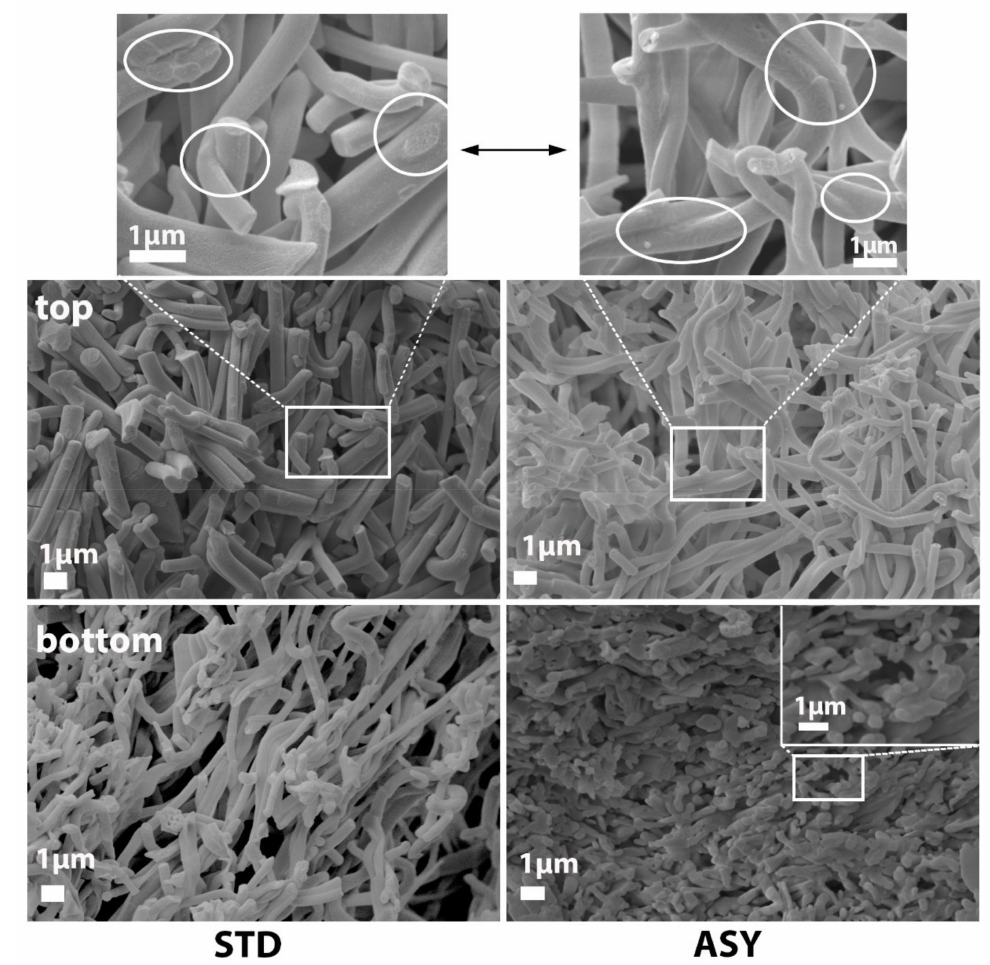
Figure 6. Comparative SEM micrographs of the ( top ) and ( bottom ) fractured surfaces of the Al 2 O 3 samples fabricated in STD and ASY graphite arrangements at a 1300 ◦ C sintering temperature. White circles on the high magnification images show the contact areas of the